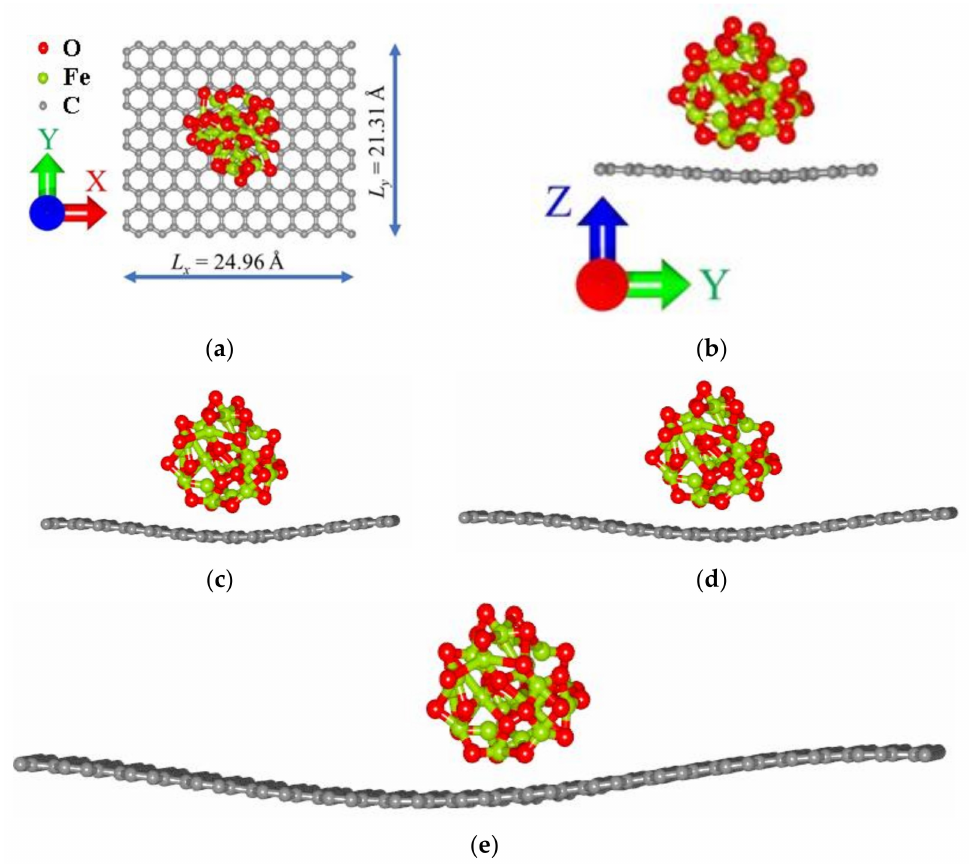
Figure 1. The atomic supercell of the membranes G/Fe 3 O 4 after optimization by the SCC DFTB method, with mass ratios: ( a ) 1:1 top view; ( b ) 1:1 side view with translation vectors L x and L y ; ( c ) 3:7 side view; ( d ) 1:4 side view; ( e ) 1:9 side